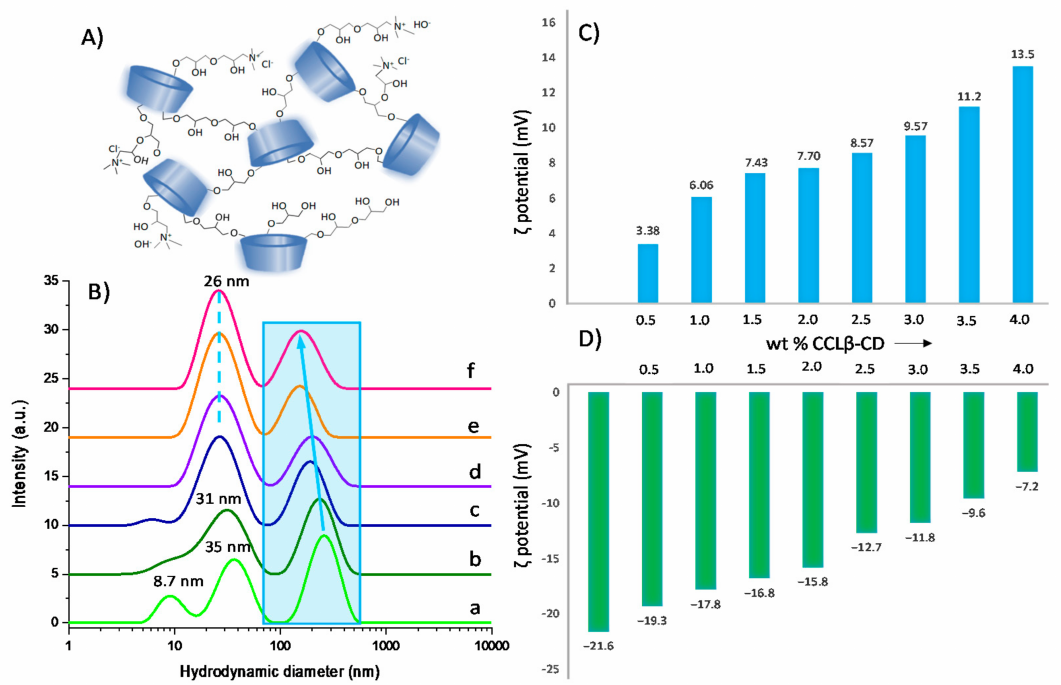
Figure 6. Schematic structure of cross-linked β -cyclodextrin oligomers ( A ); DLS data of mixtures prepared with 2 mg/mL CALB and different wt. % of CCL β -CD (a: 0%; b: 0.5%; c: 1.5%; d: 2.5%; e: 3.0%; f: 4.0%) ( B ). Zeta potential of aqueous solutions prepared increasing wt. % of CCL β -CD without ( C ) and with 2 mg/mL CALB ( D